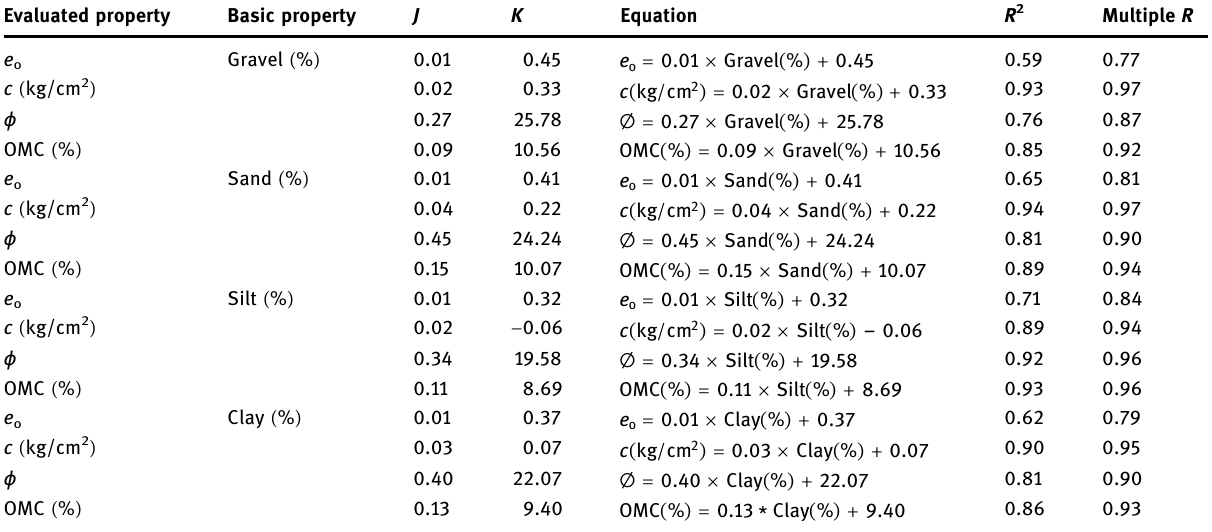
Table 3: Linear regression details for various soil characteristic for Kirkuk city Evaluated property